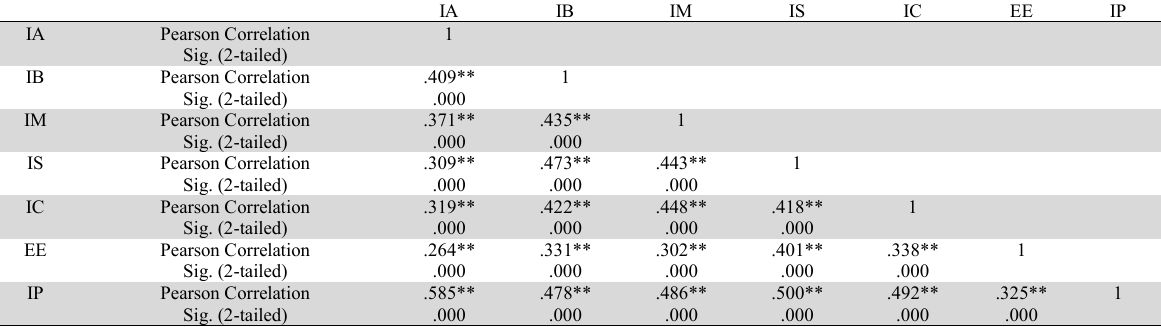
Pearson correlation